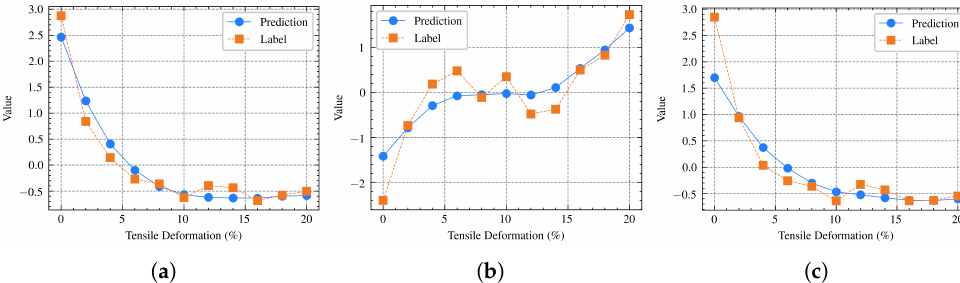
Figure 4. The line charts of the comparison between the prediction results obtained by our proposed method and the actual twin density of the material under different tensile deformations. ( a ) is the prediction result on average grain size. ( b ) is the prediction result on the twin boundaries density. ( c ) is the prediction result on average grain